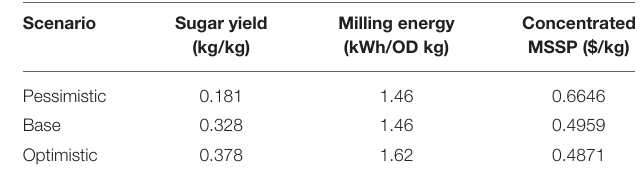
TABLE 5 | Impact of sugar yield scenarios on required milling energy and concentrated sugar